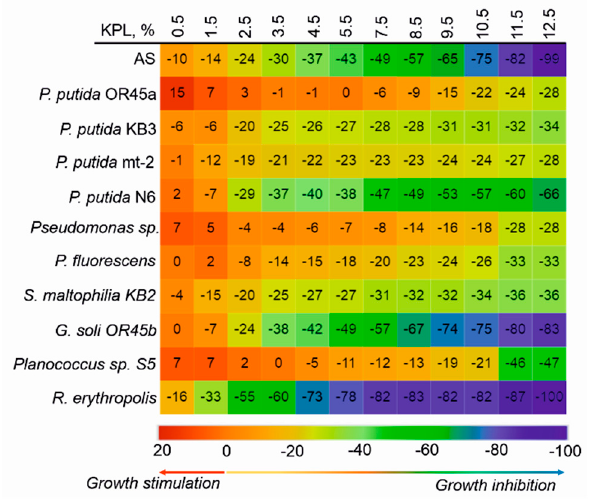
Figure 2. Effect of the different concentrations of the Kalina pond leachate (KPL) on the growth of the tested bacteria. The negative values indicate the inhibition of microbial growth whereas the positive values indicate its stimulation.